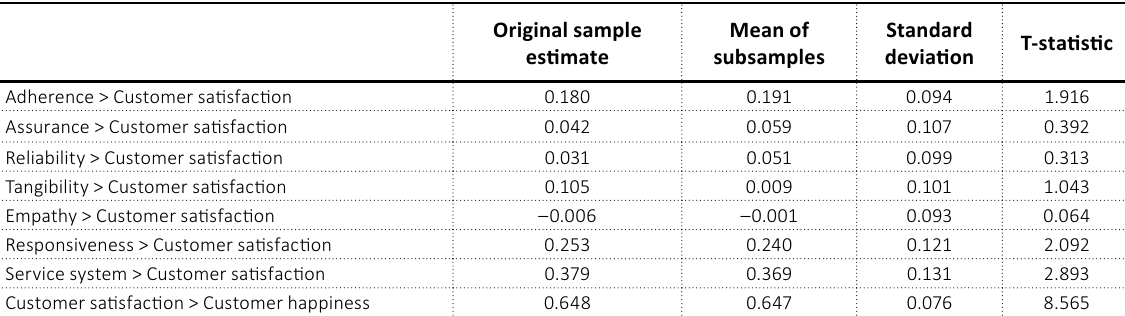
Table 5. Significance value of structural model via bootstrap